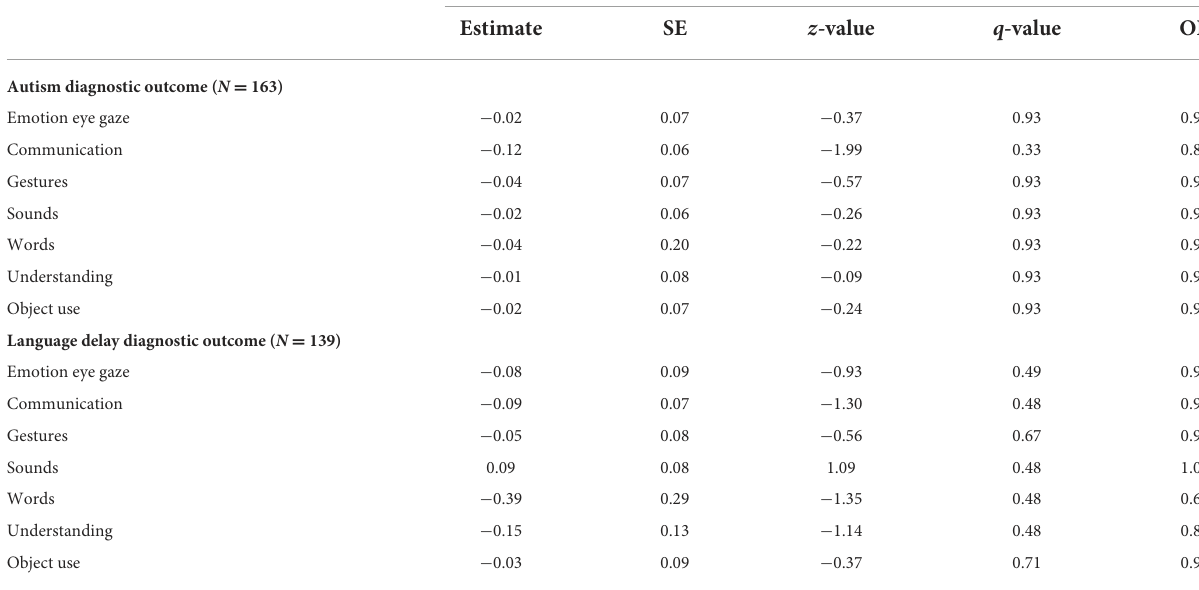
TABLE 8 Logistic regression analysis exploring main effects of social communication skills measured at 12-months on diagnostic and language outcomes measured at 24-months in HL-infants. CSBS scores